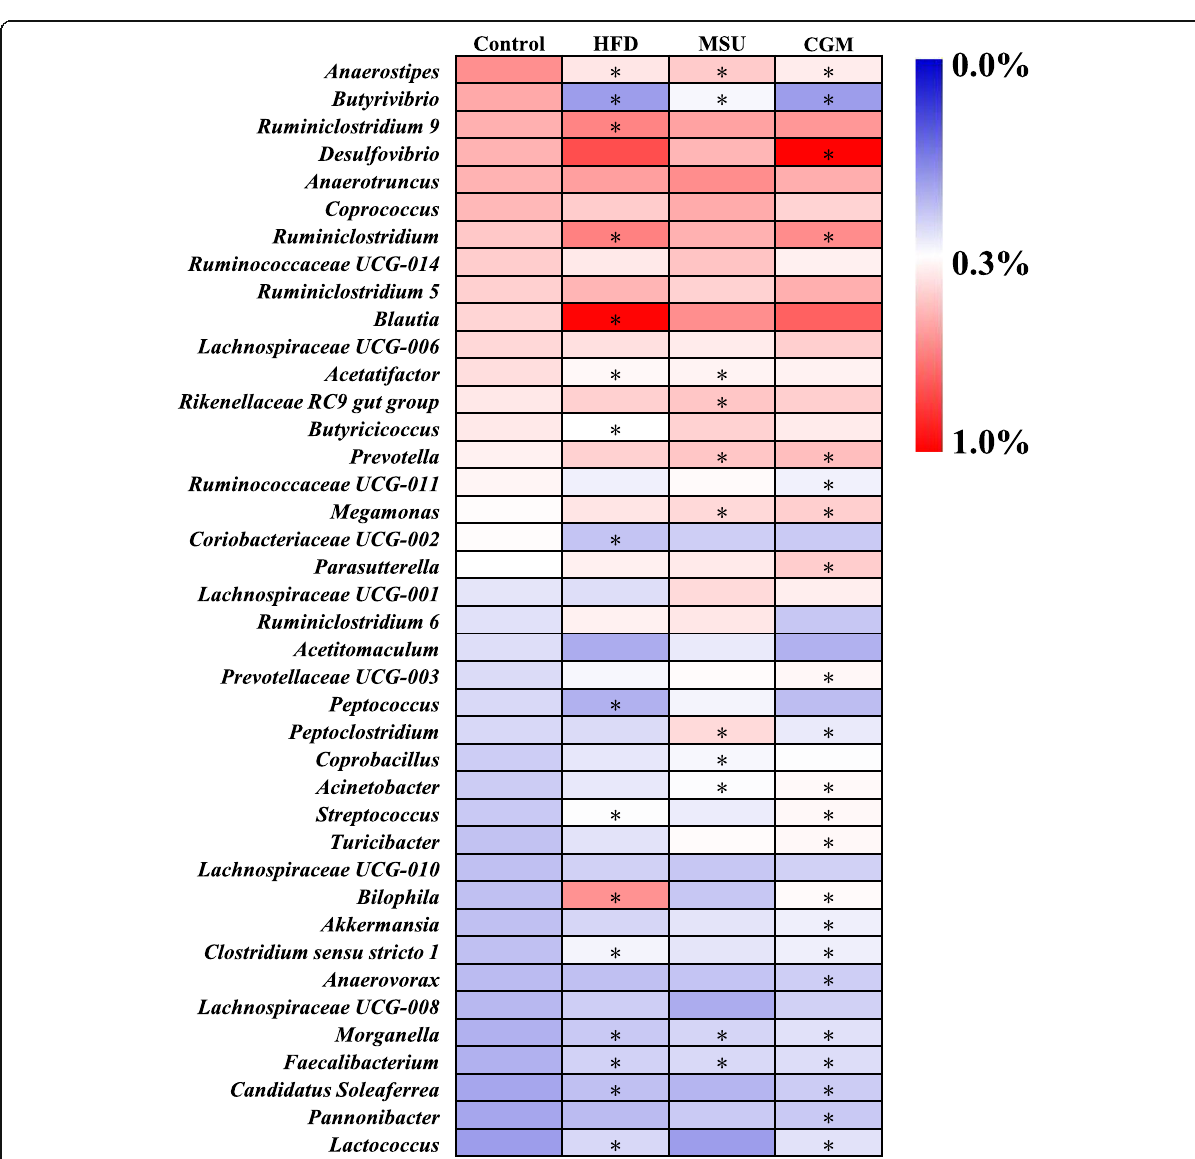
Fig. 5 Heatmap showed the relative abundance of microbial genera in the mice of four groups. “ * ” represents p <0.05 in comparison with control group; and “ ** ” represents p <0.01 in comparison with the control group. “ + ” represents p <0.05 in comparison with CGM; and “ ++ ” represents p <0.01 in comparison with CGM. CT: control group; HFD: high-fat diet group; MSU: MSU crystals injection group; CGM: the compound gout model